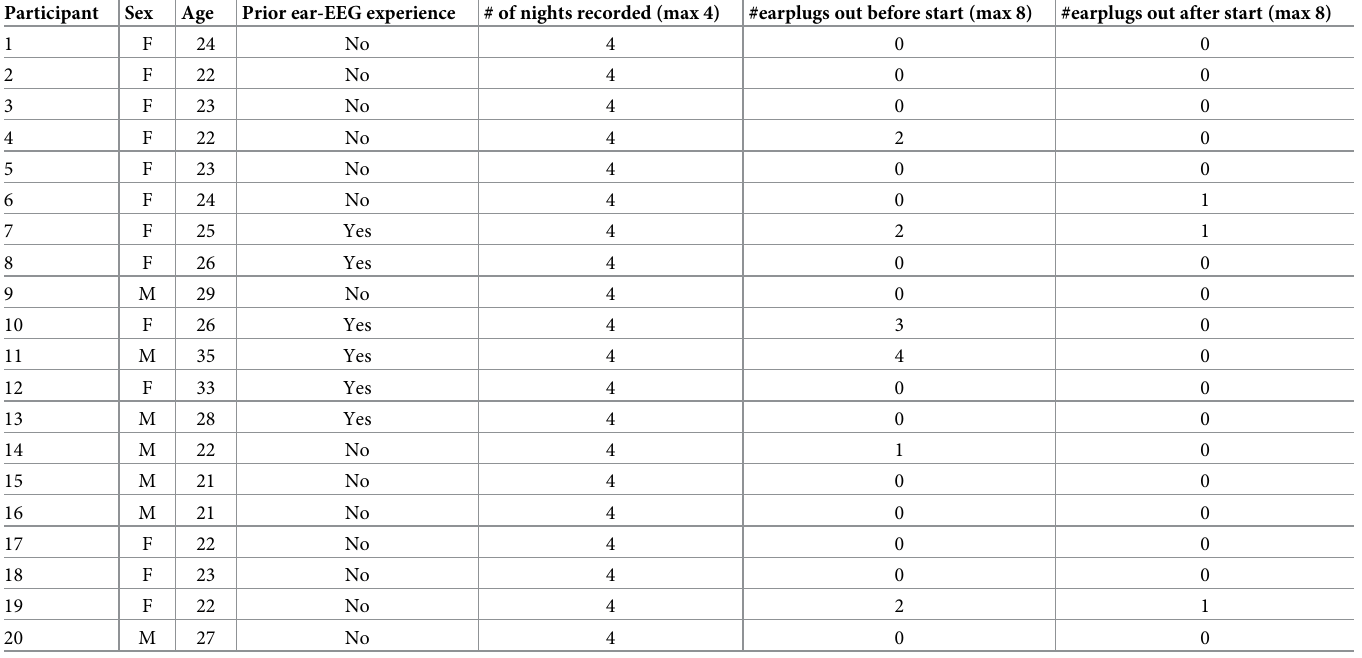
Table 1. Characteristics of study population. Each participant is given one line. Fourteen participants had no prior experience with ear-EEG. Everyone was recorded for four nights. In 3 nights, the participant removed one earplug. The rest of those nights was not